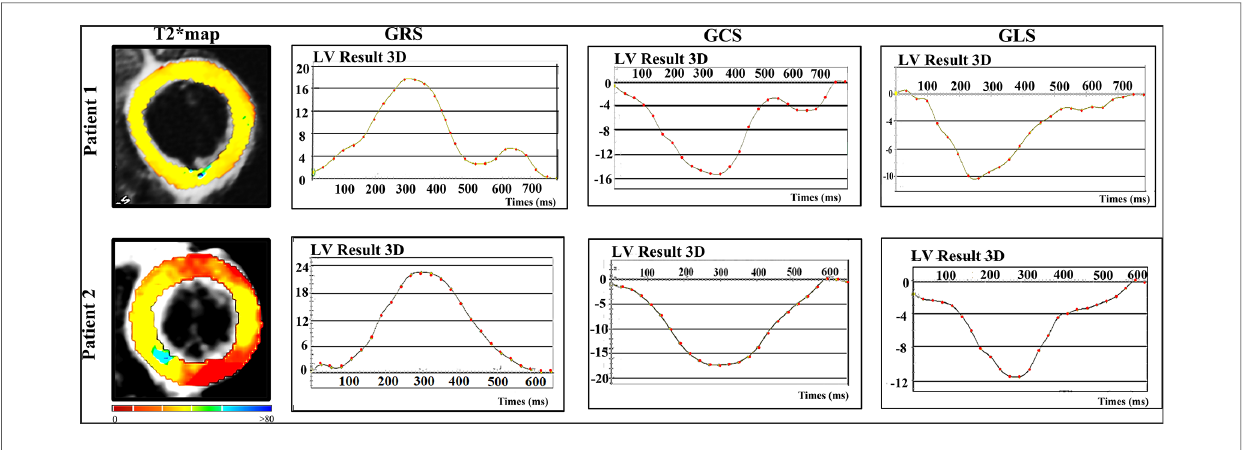
FIGURE 4 Representative examples of T2* maps and corresponding strain patterns (GRS, GCS and GLS) in two patients. Patient 1 - 38 years-old asymptomatic male with HIV diagnosis of 10 years; Patient 2 - 37 years-old male asymptomatic male with HIV diagnosis of 2 years. Abbreviations as in Figure 1 .